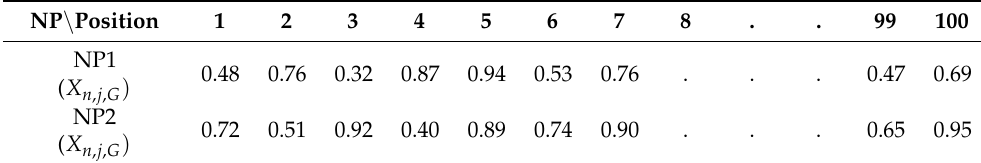
Table 6. An example with two random